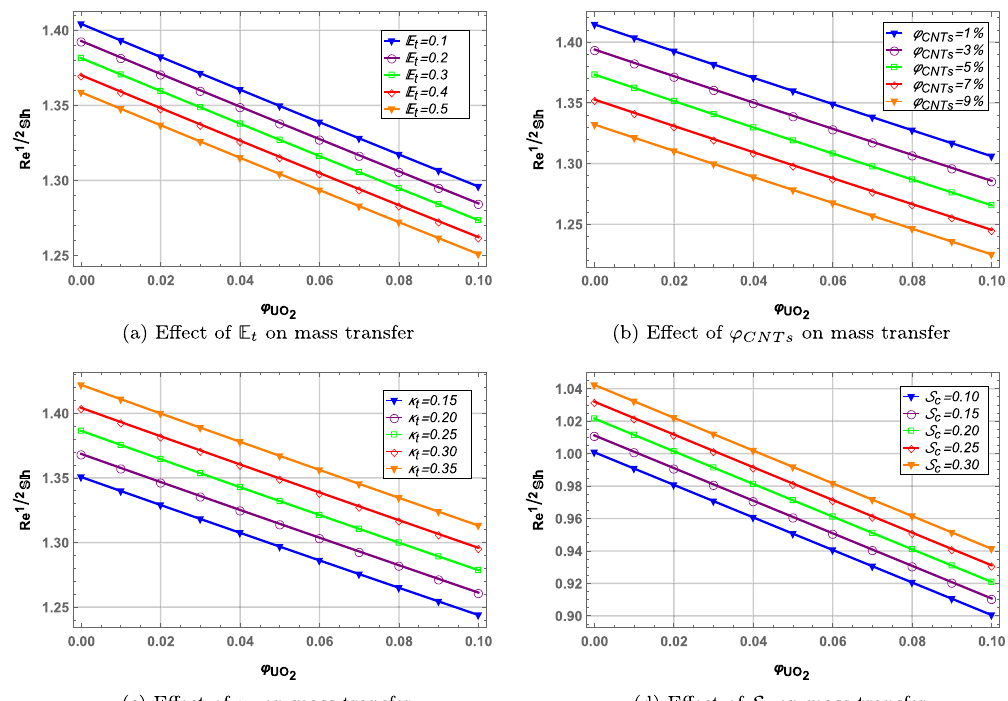
Figure 12. Mass transfer